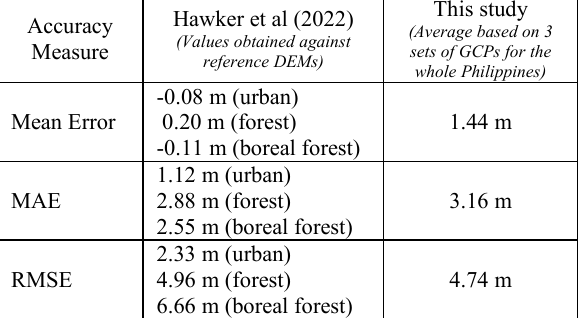
Table 8. Comparison of the accuracy evaluation results with the accuracies obtained by the FABDEM developers as reported in Hawker et al.